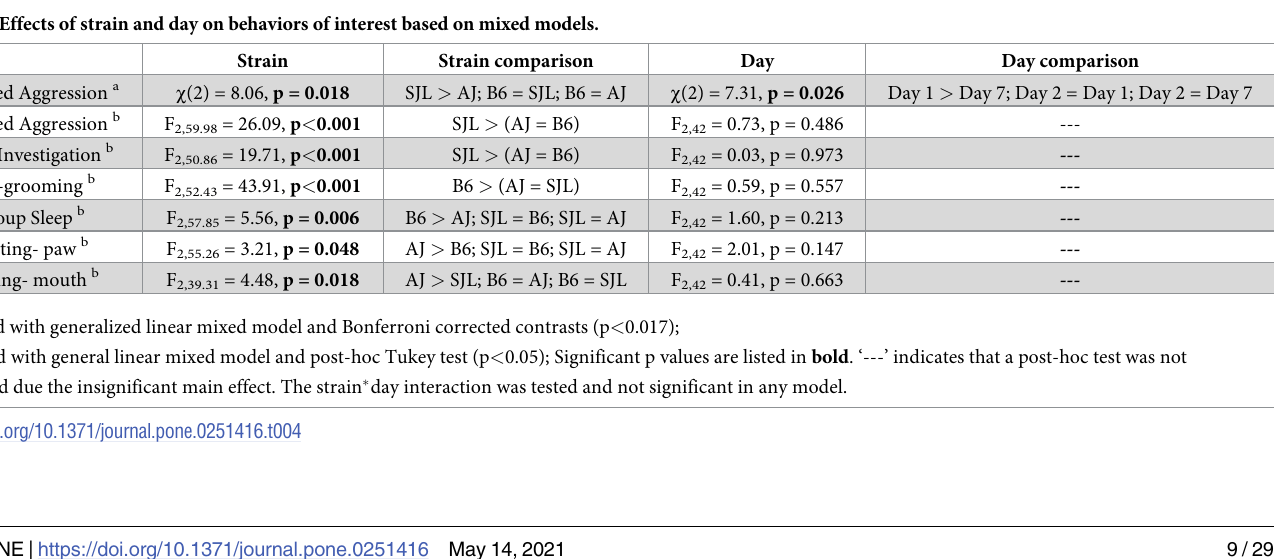
(Table 3). Strain did not affect urine PC3 or nest PC2. In terms of covariate measures, strain significantly impacted average nest complexity score, but did not impact Landau’s H. (Table 3). AJ mice built the most complex nests, followed by B6, and SJL (Tukey: p < 0.05). In this study, the strain pattern of sweat PC1 matches that of allo-grooming, while patterns of nest PC1 and urine PC2 match that of aggression. Therefore, VOCs with high loading on these PCs were chosen for further analysis. Scores on sweat PC1 were positively correlated